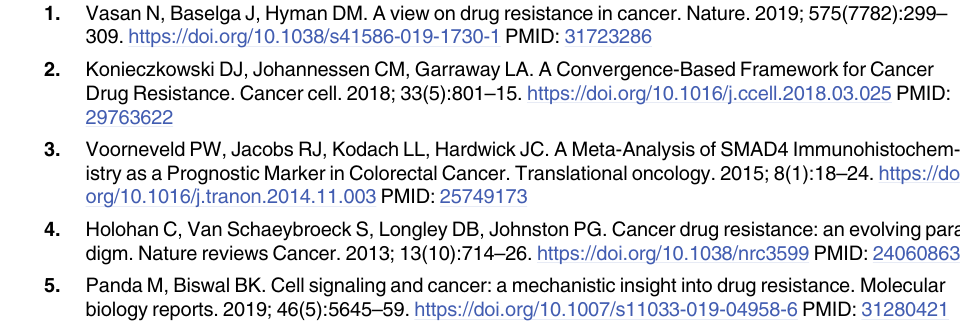
S1 Table. The key information of the articles related to SMAD4 mutation study. OS, overall survival; HR, Hazard